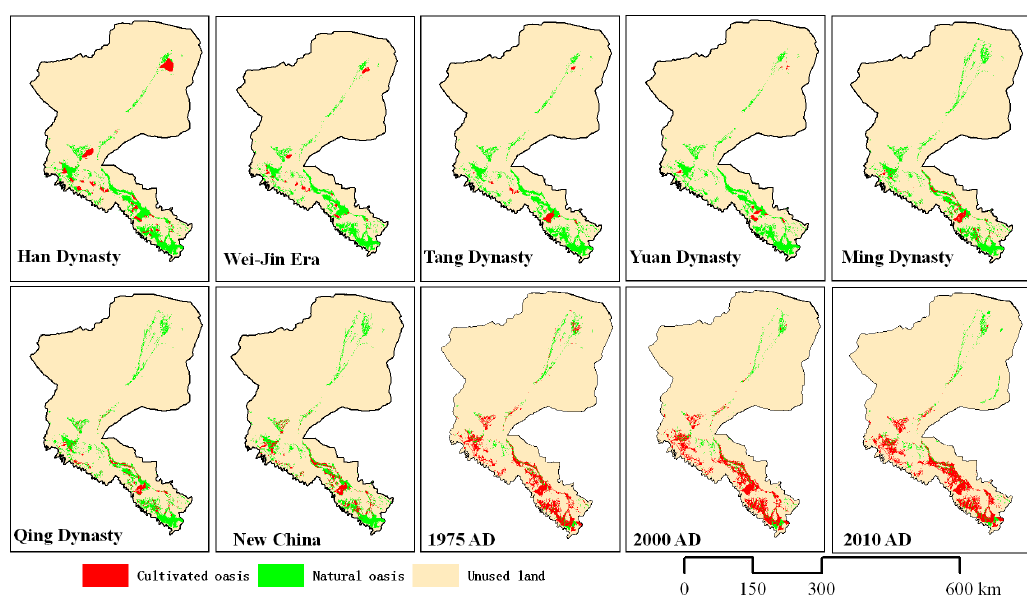
Figure 4. Land use reconstructions in historical periods and land use through image interpretation in recent periods in midstream and downstream areas of the HRB. (It should be noted that the grassland, forest and water or wetland were combined with the natural oases, and the farmland and built-up land were combined with cultivated oases in the land use in 1975, 2000 and